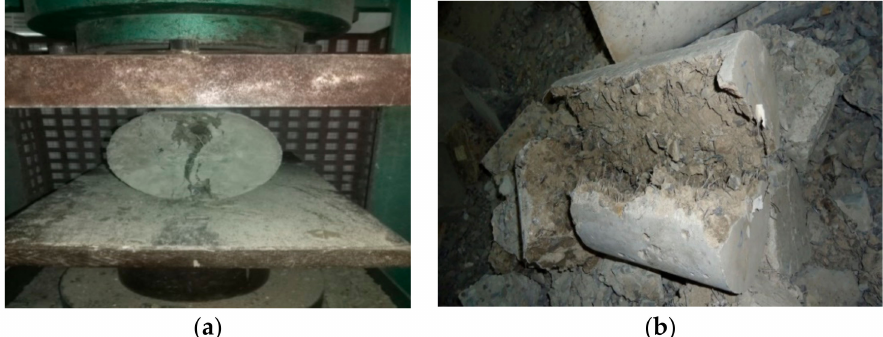
Figure 7. ( a ) The splitting tensile load application on a cylindrical specimen; and ( b ) the failure of the specimen after the test.